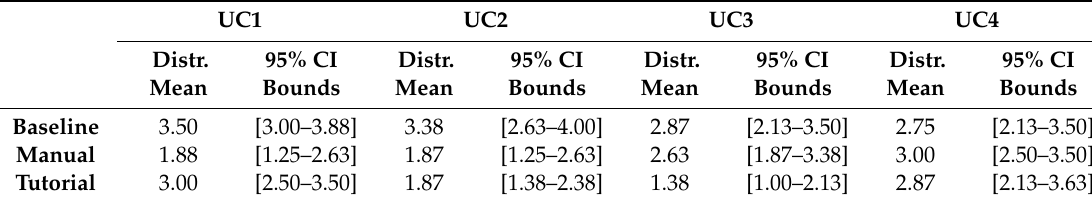
Table 9. Means and 95% CI upper and lower bounds of bootstrapped experimenter rating distributions by the three experimental conditions for the four